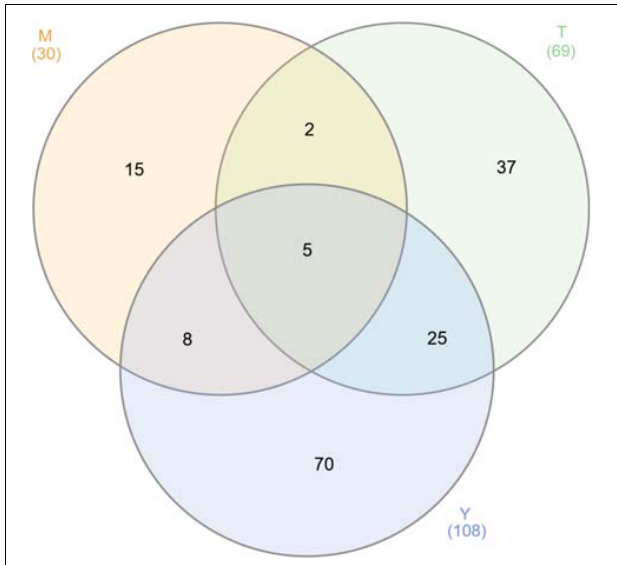
FIGURE 1 | Venn diagram of GAPDH interacting proteins. We found 207 proteins interacting with GAPDH through two different approaches and performed independently for the three stages of P. lutzii life cycle. The numbers on the diagram represent the number of proteins interacting with GAPDH in mycelium (M), mycelium-to-yeast transition (T) and yeast (Y) P. lutzii phases.